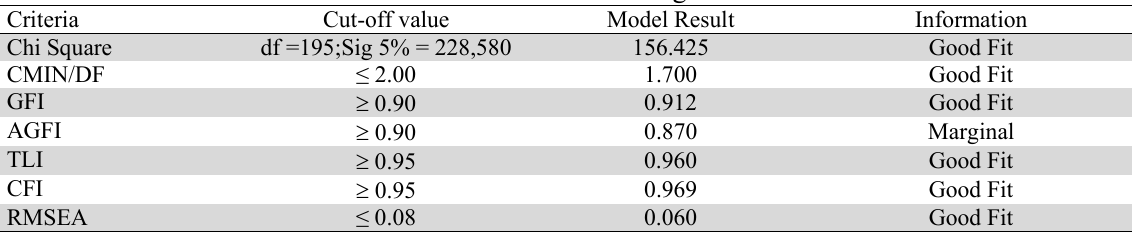
Fig. 2. Structural Model Graphic for SEM Stage I Examination Results for Goodness of Fit Overall Model Stage